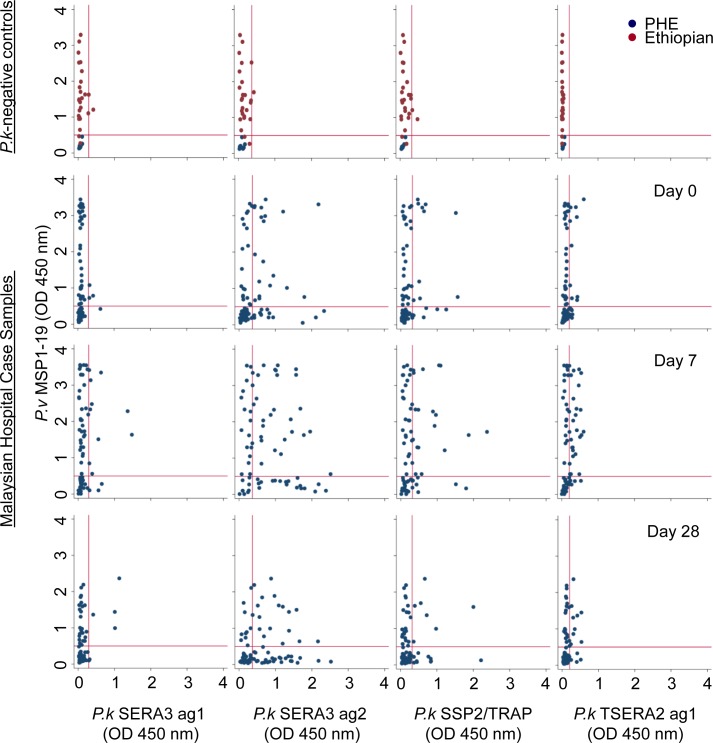
Endemic and P. knowlesi-negative sera reactivity to Plasmodium knowlesi-specific antigens.Scatter plots showing sera reactivity to: P. vivax MSP1-19 with P. knowlesi SERA3 ag1 (column 1), SERA3 ag2 (column 2), SSP2/TRAP (column 3) and TSERA2 ag1 (column 4) antigens. Sera samples from P. knowlesi-negative controls n = 55 (row 1; PHE UK malaria naïve (blue), Ethiopian children (red)) and Malaysian hospital case sera samples from days 0 (n = 92), 7 (n = 72) and 28 (n = 77) of diagnosis (rows 2–4, respectively). The red line in each graph represent the cut off values for the respective P. knowlesi antigen and was calculated based on Public Health England negative control sera samples (average ODs ± (3xSD)): The vertical cut off line is based on PvMSP1-19 = 0.501. The horizontal cut off line for the P. knowlesi antigens were based on the following values: SERA3 ag1 = 0.292; SERA3 ag2 = 0.366; SSP2/TRAP = 0.322 and TSERA2 ag1 = 0.208.